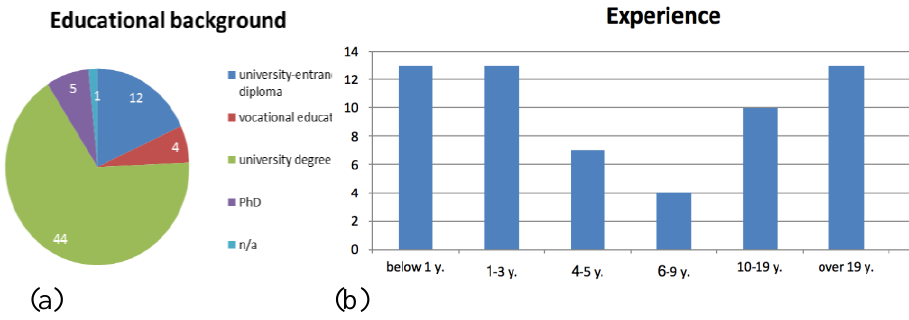
Figure 5. Educational background and working experience of the respondents